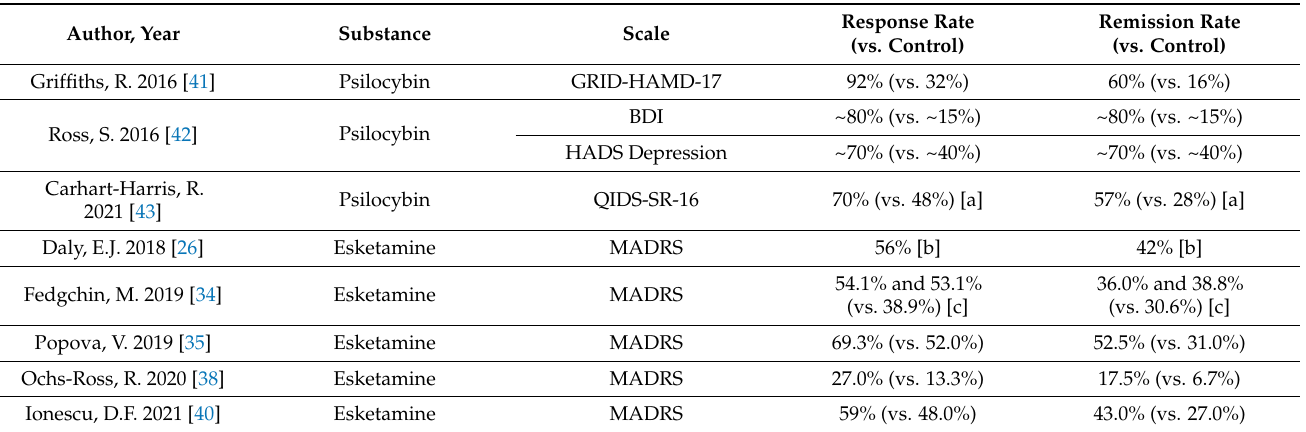
Table 4. Response and remission rates compiled at 4–7-week follow-up (time frames vary over different studies).